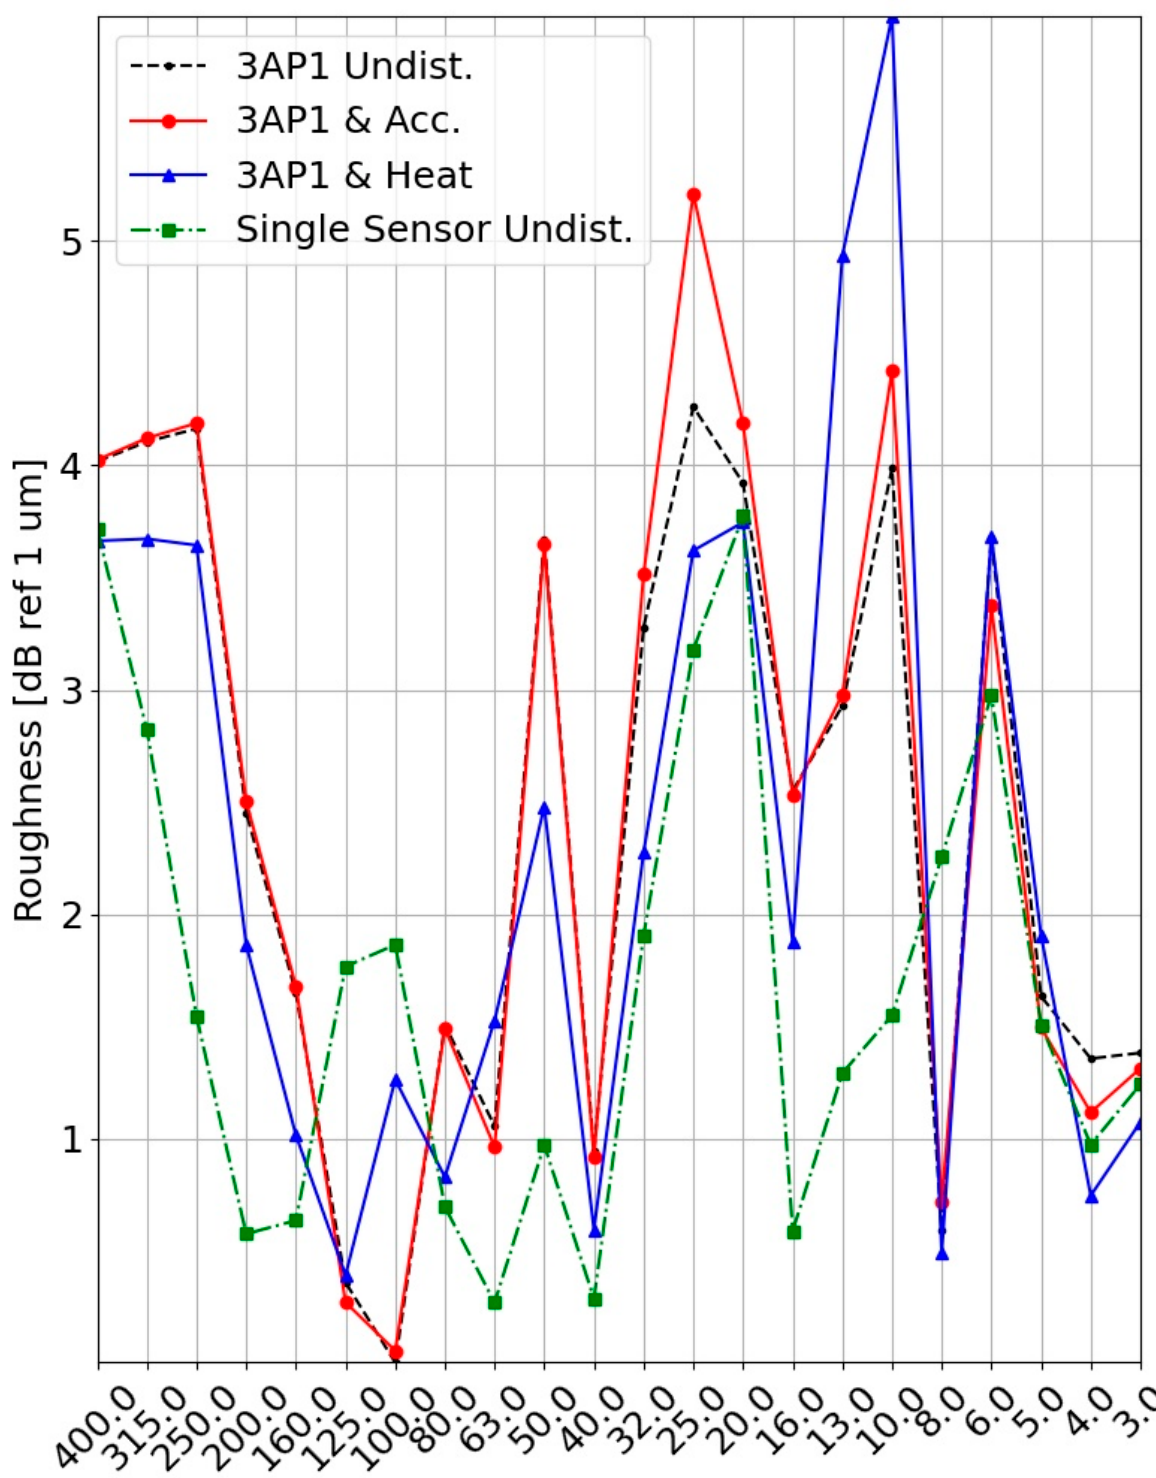
Figure 5. Absolute error of acoustic roughness for undisturbed measurements (chord method and single sensor), for constant velocity (undisturbed), acceleration during measurement and under influence of an additional heat flux.